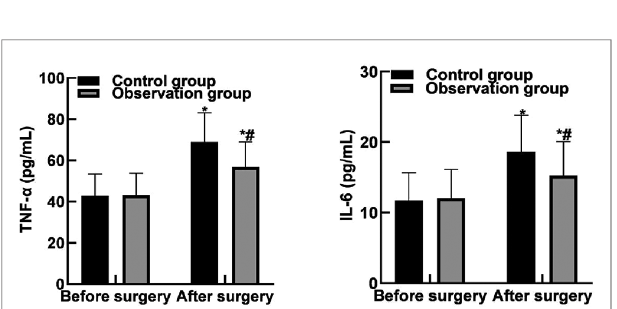
FIGURE 3 | Comparison of immune function indicators between the two groups . Note: Compared with before surgery, * P <0.05. Compared with the control group, # P <0.05.